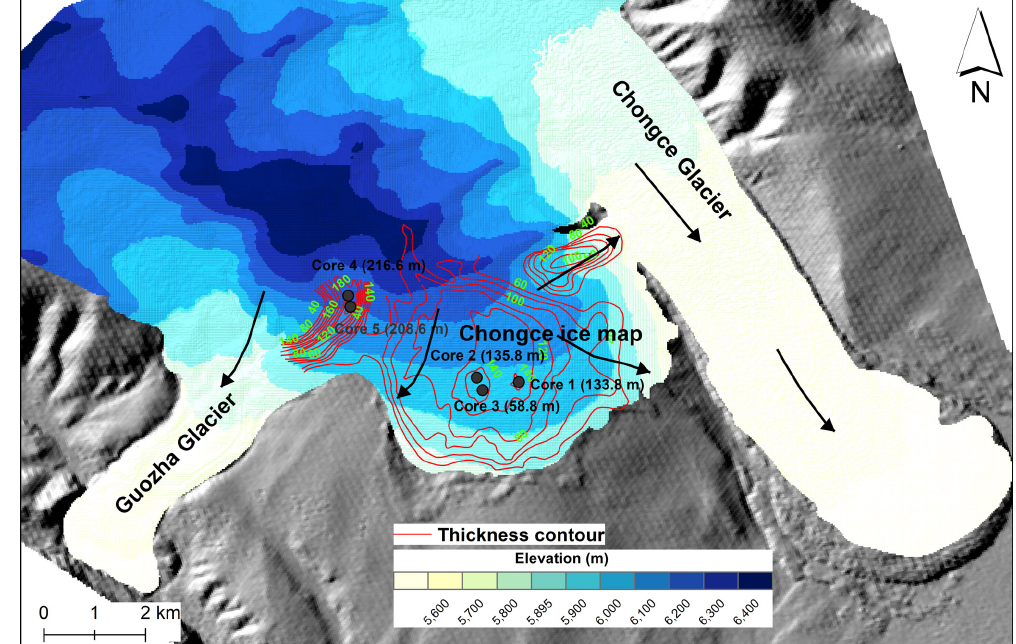
Figure 1. Map showing the topography (red contour lines) and ice thickness (blue color ramp) of the Chongce ice cap with the drilling sites (black dots). The black arrows show the ice flow direction. The effects of the Chongce Glacier surging on the mass balance of the Chongce ice cap are limited, if any (Wang et al., 2018), because the ice flows from the Chongce ice cap into the Chongce Glacier, and the surged area is confined within the Chongce Glacier (Yasuda and Furuya,